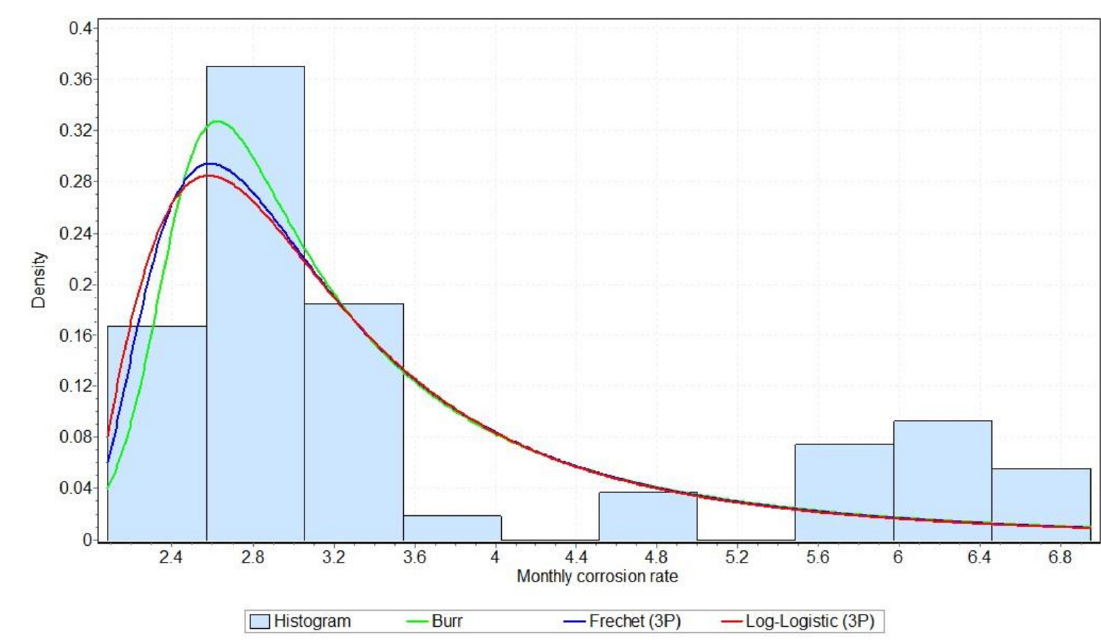
Figure 11. Empirical PDF and the three best fitted three-parameter distributions of the NiTi-1 alloy corrosion rate in the air environment.